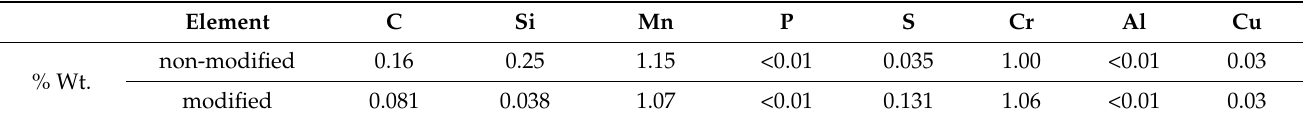
Table 1. Chemical composition of the investigated modified 16MnCrS5 steel in weight percentage in comparison with standard non-modified 16MnCrS5